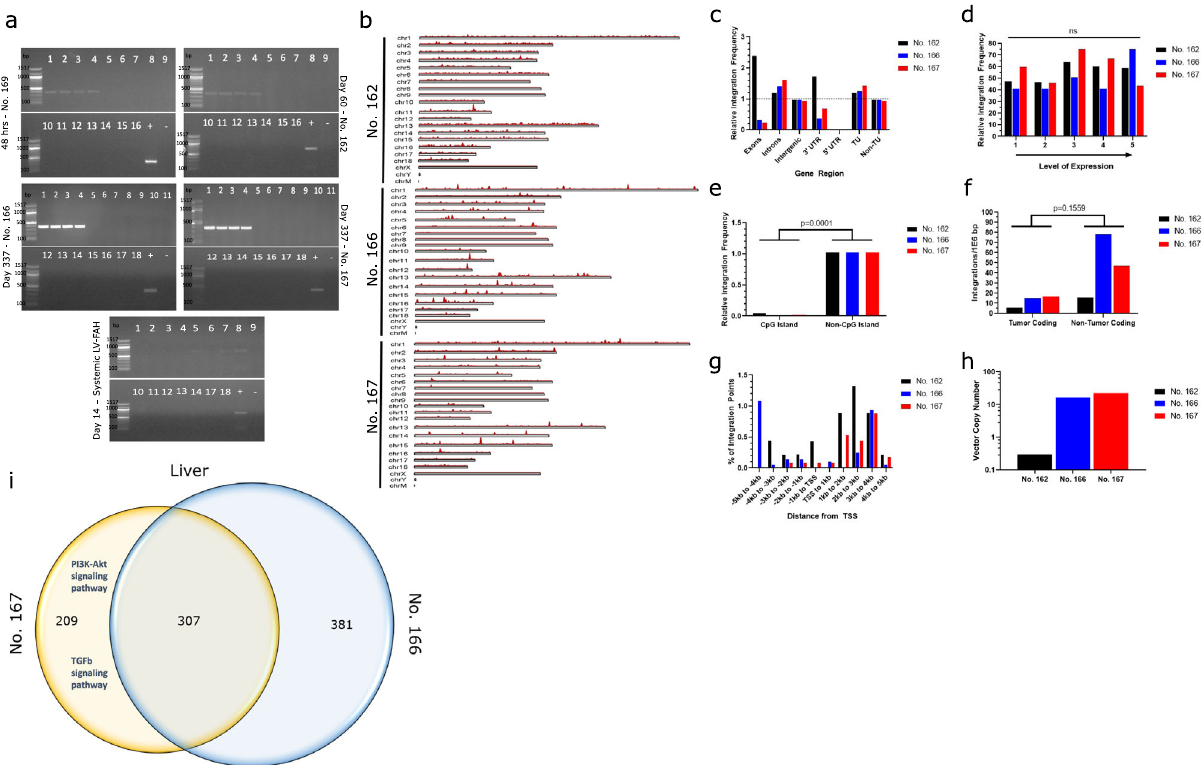
Fig. 4 | LV-huFAH shows a benign integration pro fi le in pig hepatocytes after in vivo exposure portal vein delivery. a Biodistribution of LV-FAH asdetermined by selective PCR ampli fi cation of long terminal repeats over 48h, 60days, and 337days in animals that received portal vein (No. 169, No. 162, No. 166, No. 167, respectively) and systemic injection of LV-FAH. Numbers represent the following tissues:(1)rightlateralliver,(2)rightmedialliver,(3)leftlateralliver,(4)leftmedial liver,(5)spleen,(6)kidney,(7)pancreas,(8)duodenum,(9)jejunum,(10)ileum,(11) colon, (12) mesenteric lymph node, (13) heart, (14) right lung, (15) left lung, (16) mediastinal lymph node, (17) testes or ovaries, (18) brain. This experiment was repeated with three primer pairs with similar results. b Chromosomal maps of integration events found in No. 162, No. 166, and No. 167 livers. c Relative LV